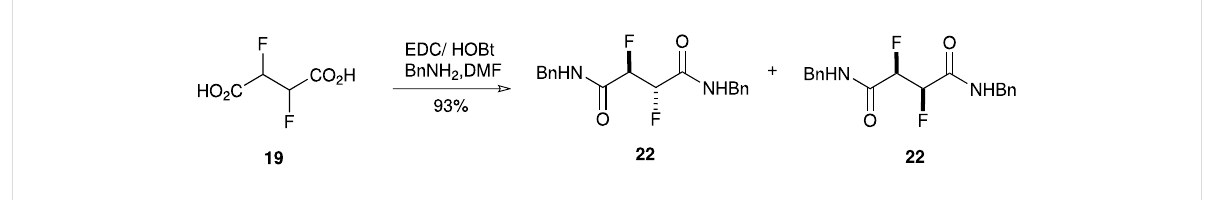
Scheme 10: The synthesis of stereoisomers of erythro - and threo - 22 . These isomers could be separated by chromatography.